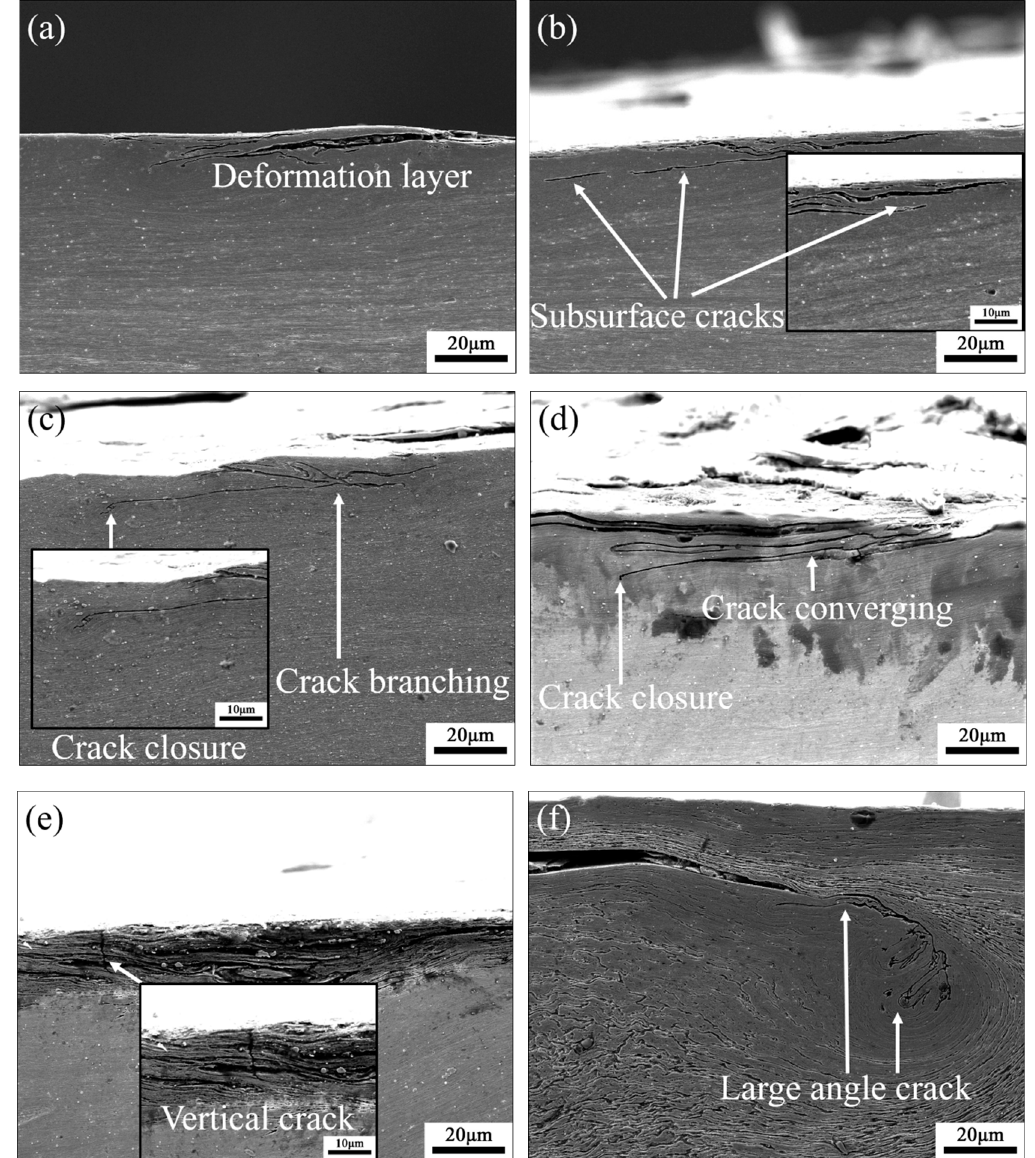
Figure 8. Micro-cracks in the cross-sections of the steels tempered at 550 °C after wear for different time, ( a ) 30 min, crack expanding inward; ( b ) 30 min, sub-surface crack expanding outwards; ( c ) 60 min, crack propagating; ( d ) 60 min, crack converging; ( e ) 120 min, vertical crack; ( f ) 120 min, sub-surface large-angle crack.